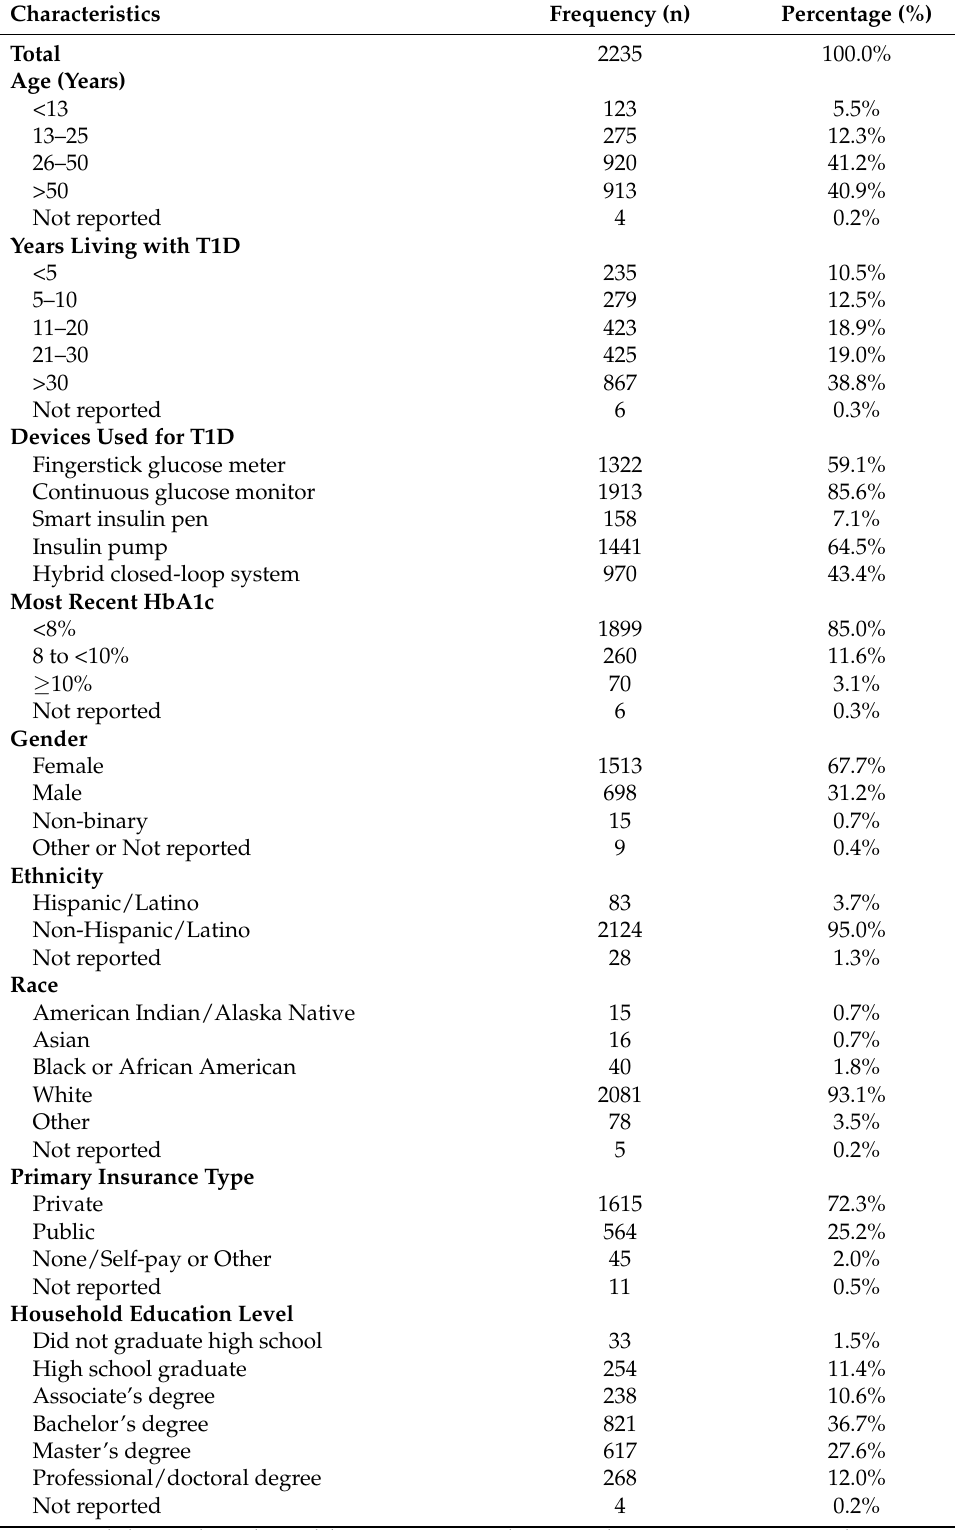
Table 1. Demographic and Clinical Characteristics of Survey Respondents